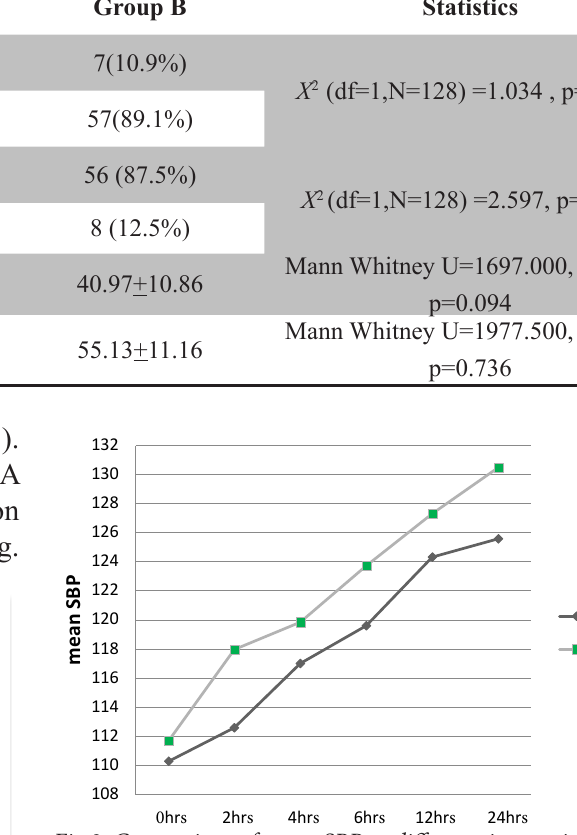
Fig 2. Comparison of mean SBP at different time